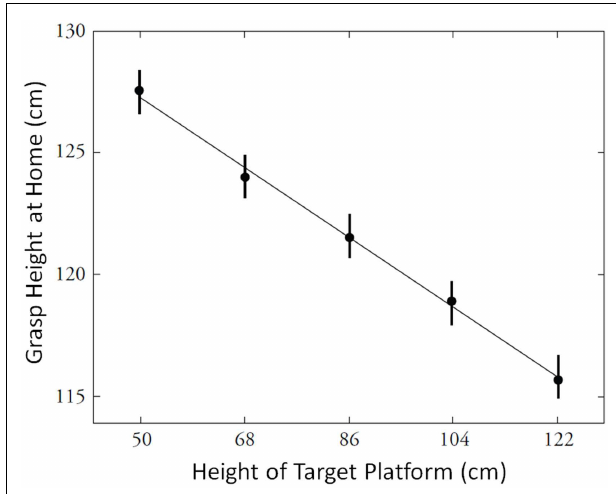
FIGURE 9 |The grasp height effect . From Cohen and Rosenbaum (2004).